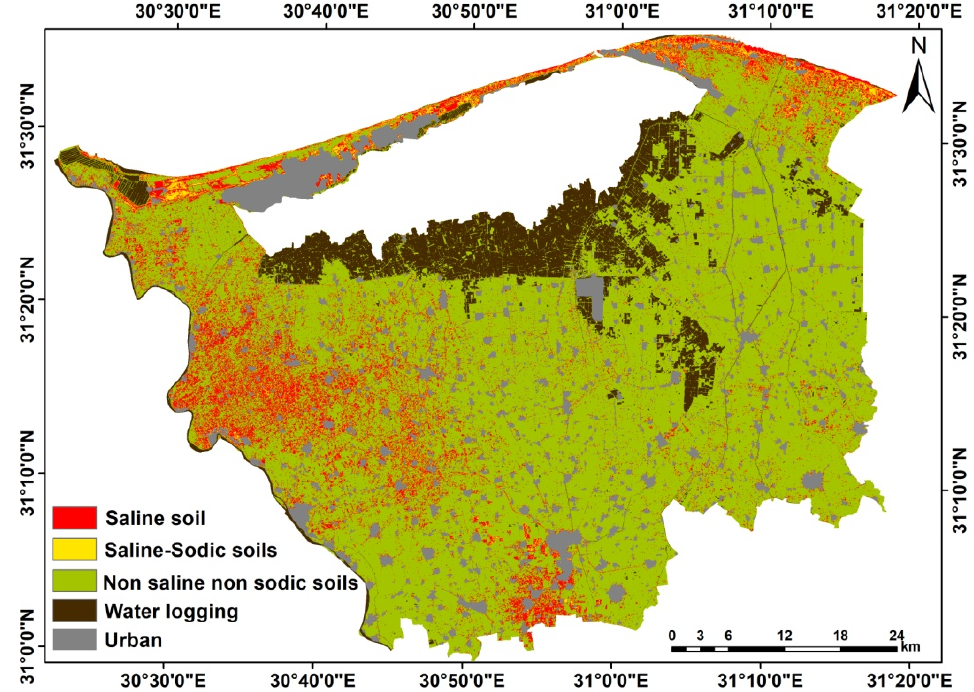
Figure 14. A 2021 map showing the salt-affected soils in the study area. Table 6. Accuracy assessment using error matrix in 2016 based on soil survey of 20 soil profiles.